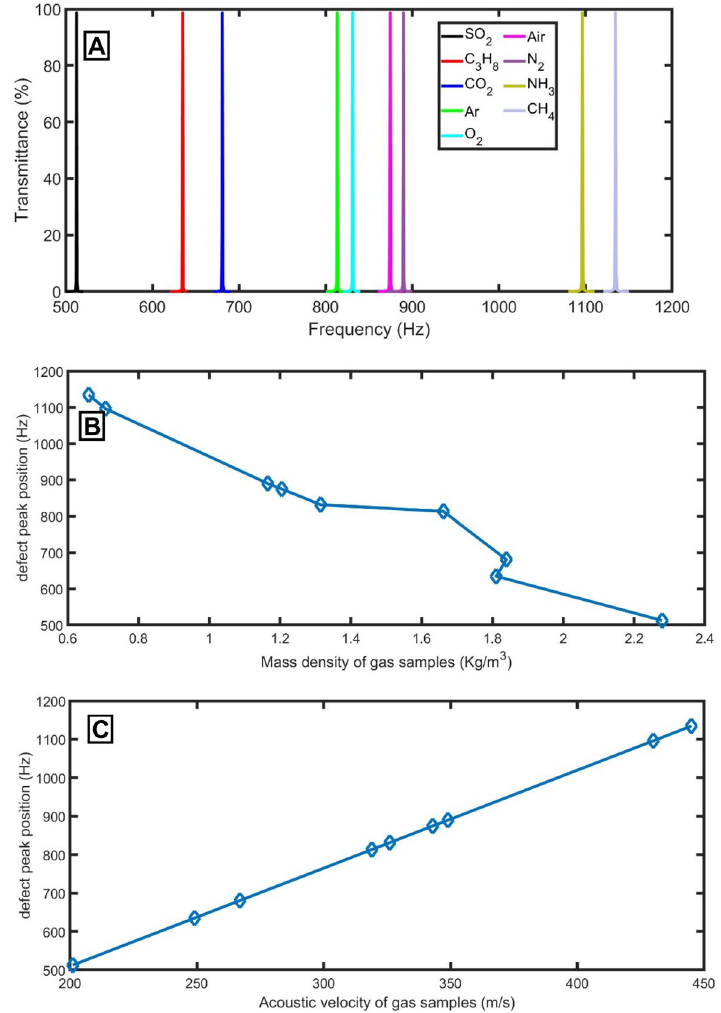
Figure 10. ( A ) the transmittance of different gas samples at the selected conditions, ( B ) the defect peak position versus the mass density for each gas sample, and ( C ) the defect peak position versus the acoustic velocity for each gas